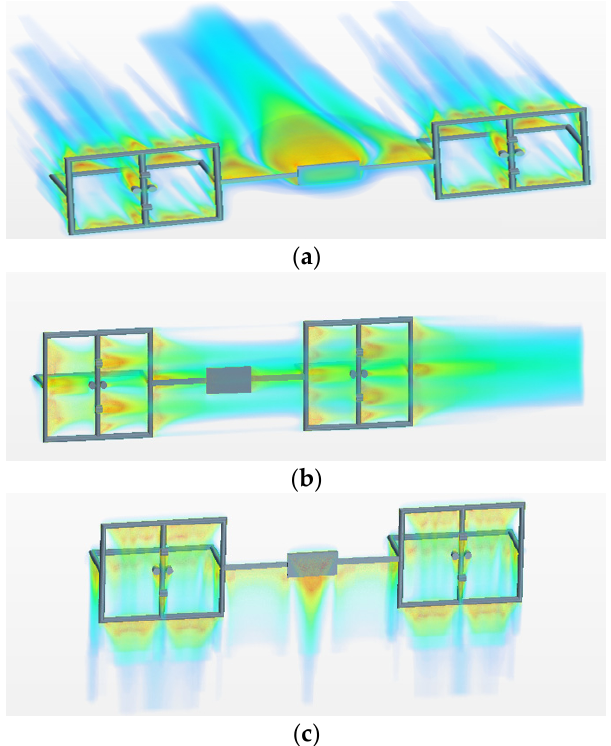
Figure 8. Simulation view of the transportation system of two Seaperch UUVs (developed with STAR-CCM+ [62]). ( a ) Heave; ( b ) Surge; ( c ) Sway.